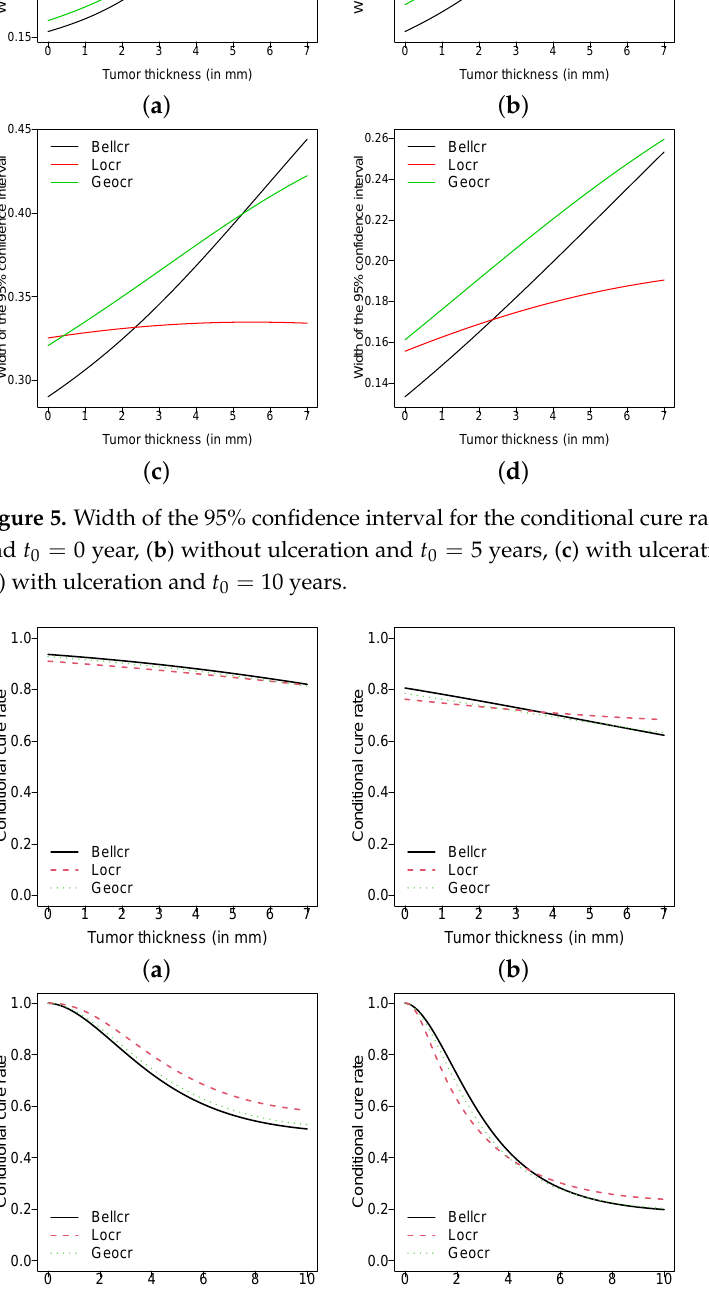
in Equation (9)) for t 0 = 5 years: ( a ) without 0